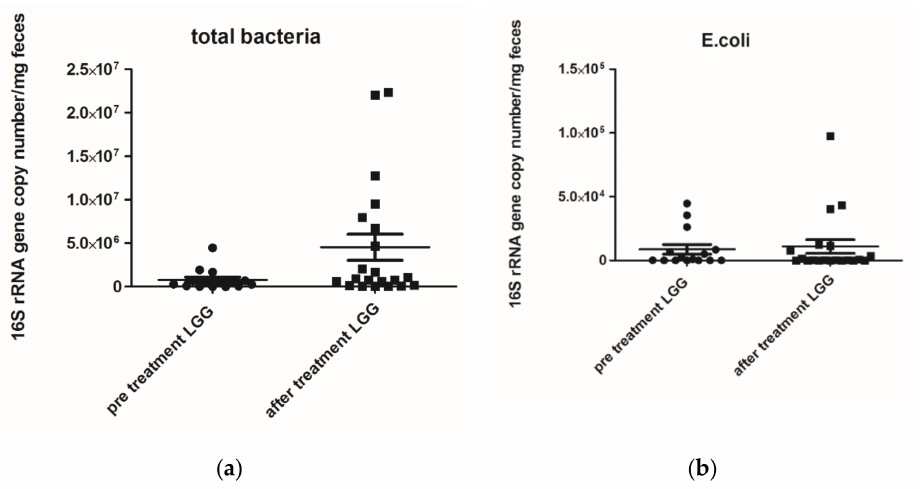
Figure 1. ( a ) Total bacterial genome (mg / faeces) pre- and post-treatment with Lactobacillus rhamnosus ATCC 53103 (LGG) p value 0.0400; ( b ) Escherichia coli ( E. coli ) 16S rRNA gene copy number (mg / faeces) pre- and post-treatment with Lactobacillus rhamnosus ATCC 53103 (LGG) p value 0.8533. Footnote: The data are represented as black dots. 16S rRNA gene copy numbers were assessed by real-time PCR and represented 16S rRNA gene copy number / mg feces. The statistical significance was calculated by the Mann–Whitney t -test.